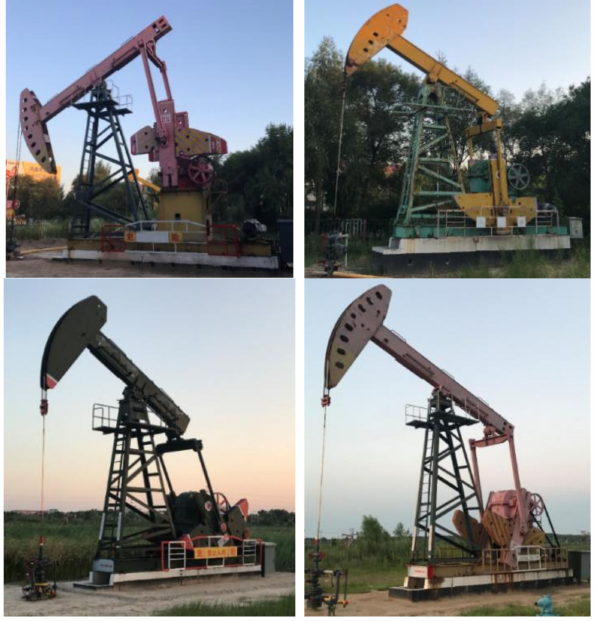
Figure 1. Sample images of oil well pump jacks onsite